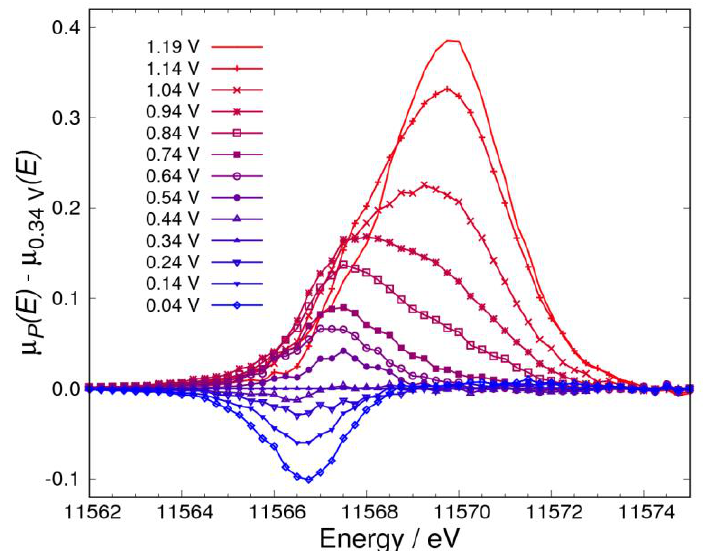
Figure 2. Pt L 3 HERFD-XAS spectra of Pt nanoparticles (NPs) under potential control in 1 M of KOH saturated with ( a ) N 2 and ( b ) O 2 .